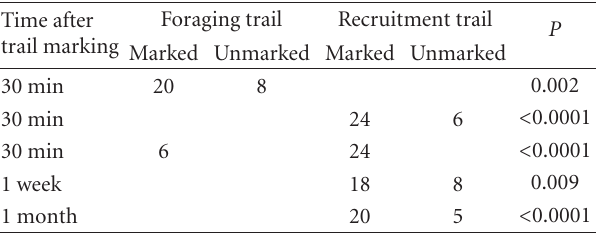
Table 1: Trail-following preference ∗ of Coptotermes gestroi workers on foraging and recruitment